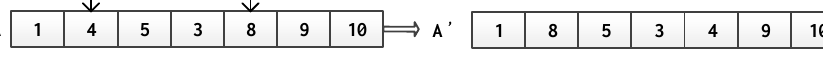
Figure 11. Mutation